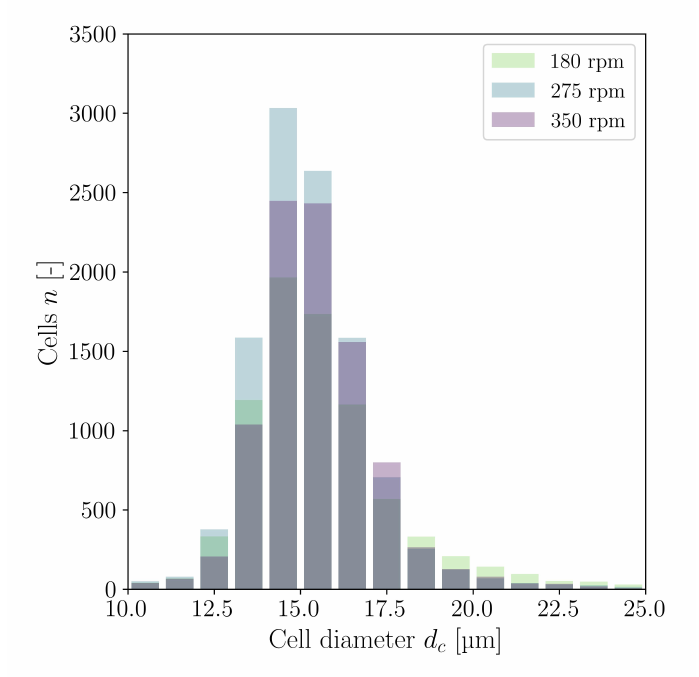
Figure A4. Cell size distribution at the time of maximum VCD measured with the CedexHiRes analyser for different stirrer speeds in the Minifors